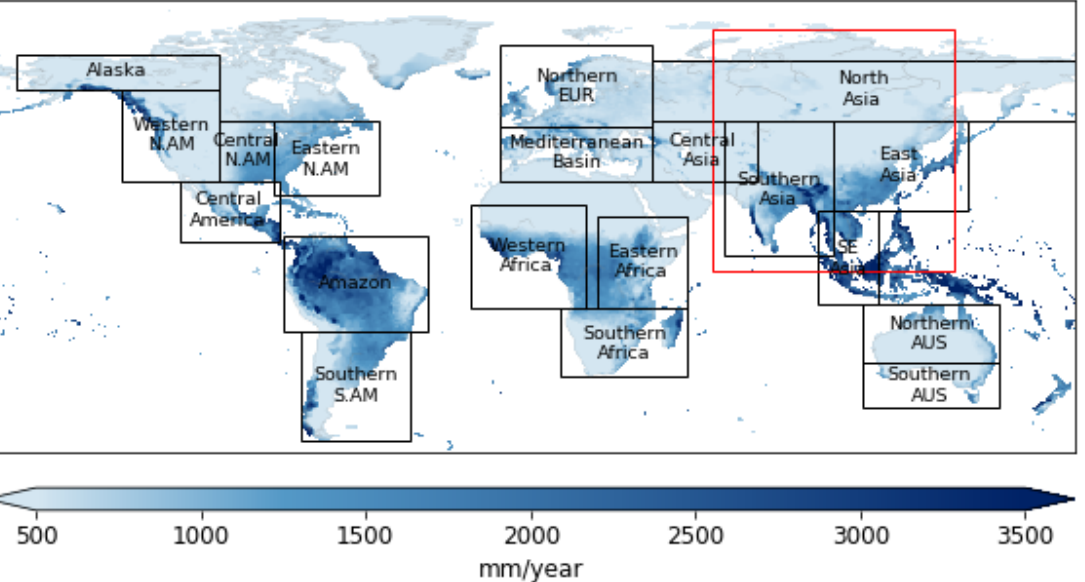
Figure 1. Regional grid scale annual average precipitation (1901–2013) (precipitation data from [22]; regions defined in [23]). (Abbreviations: N., North; S., South; SE, Southeast, AM, America; AUS, Australia; EUR, Europe). A large Asian region box is superimposed (in red).